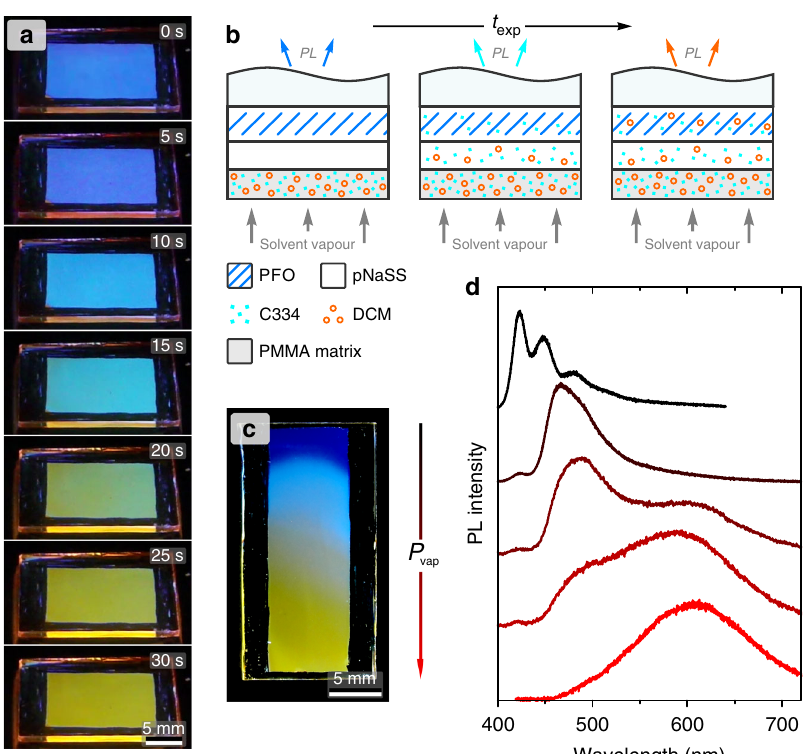
Fig. 5 One-step broad PL emission tuning in PFO-based blend fi lms. a Photographs of an inverted PFO/pNaSS/dye-blend trilayer on a glass substrate taken under UV illumination during exposure to 1 : 1 acetone : water vapour at the indicated times. b Schematic illustration of the process in a , showing the solvent-vapour-induced (quasi-)sequential diffusion of the cyan- and orange-emitting dyes with increasing exposure time, t exp . c Photograph of a similarly processed PFO-based blend fi lm but with relative solvent vapour pressure, P vap , increasing from top to bottom of the sample, resulting in a gradient of PL emission colours. d PL spectra recorded for the sample in c spanning positions from top to